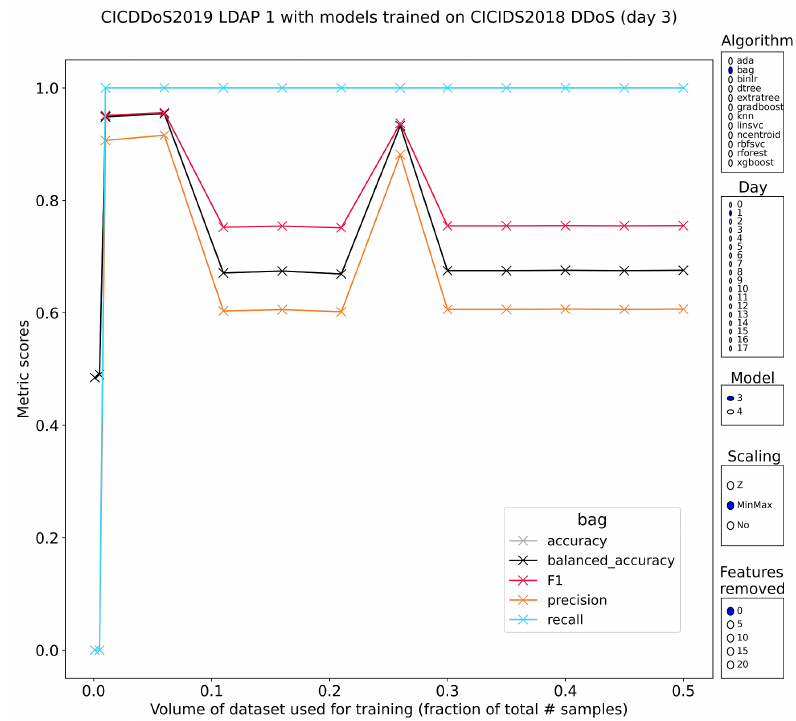
Figure 11. A rare occurrence of stable, generalized performance by a set of tree-based models. The best general performance exists for models that had little exposure to training data (<2.5% of sample count). This observation is very common, especially for the tree-based